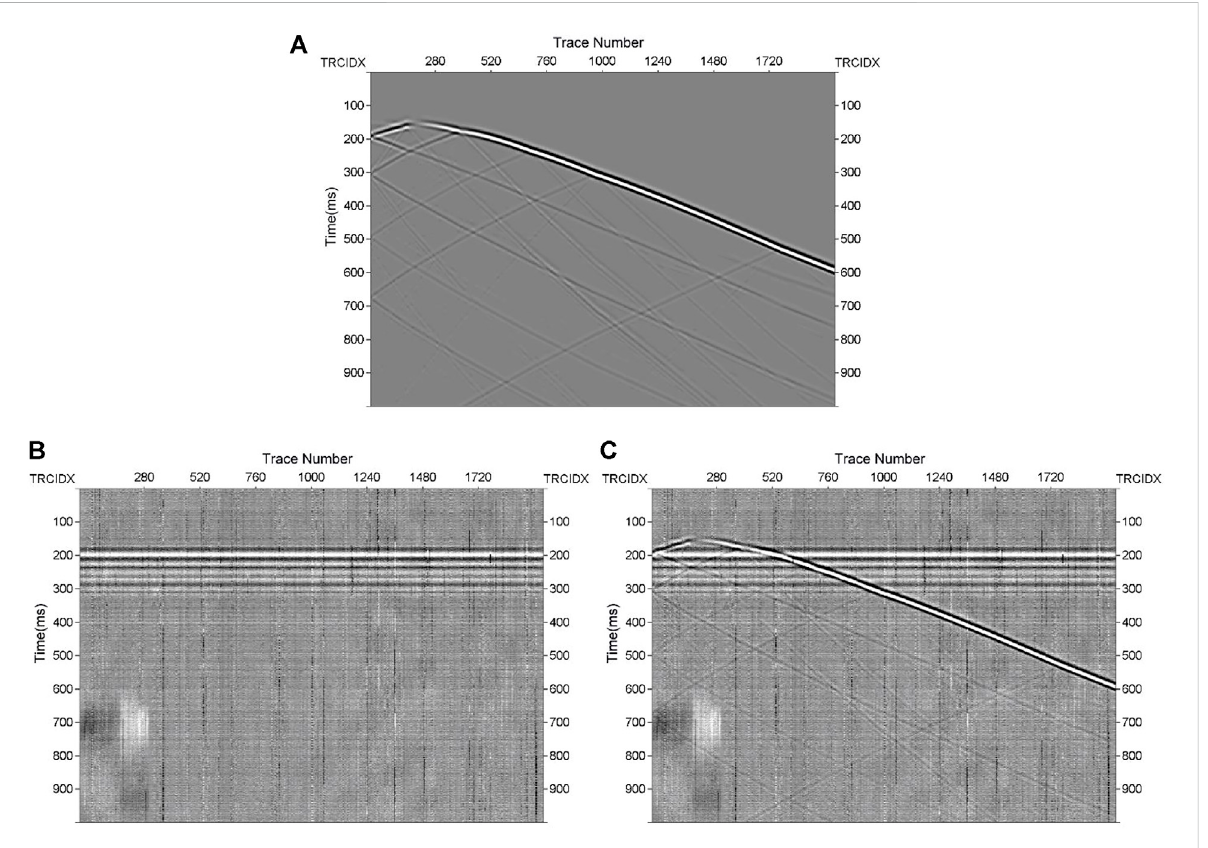
FIGURE 5 Synthetic DAS records. (A) Synthetic pure DAS record, (B) real noise record and (C) synthetic noisy DAS